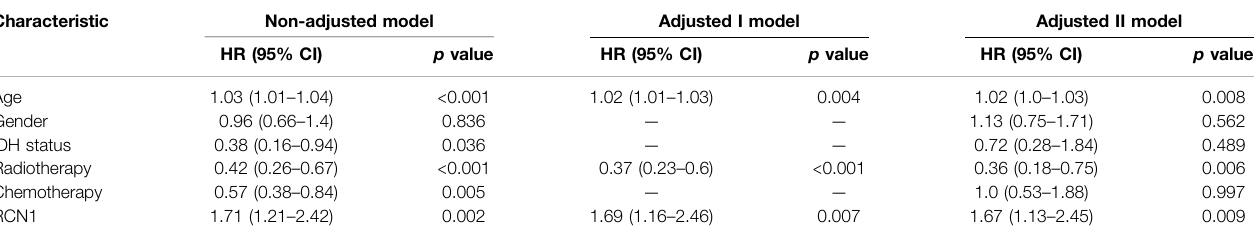
TABLE 2 | Cox proportional hazards regression models of various prognostic parameters in patients with GBM in TCGA.